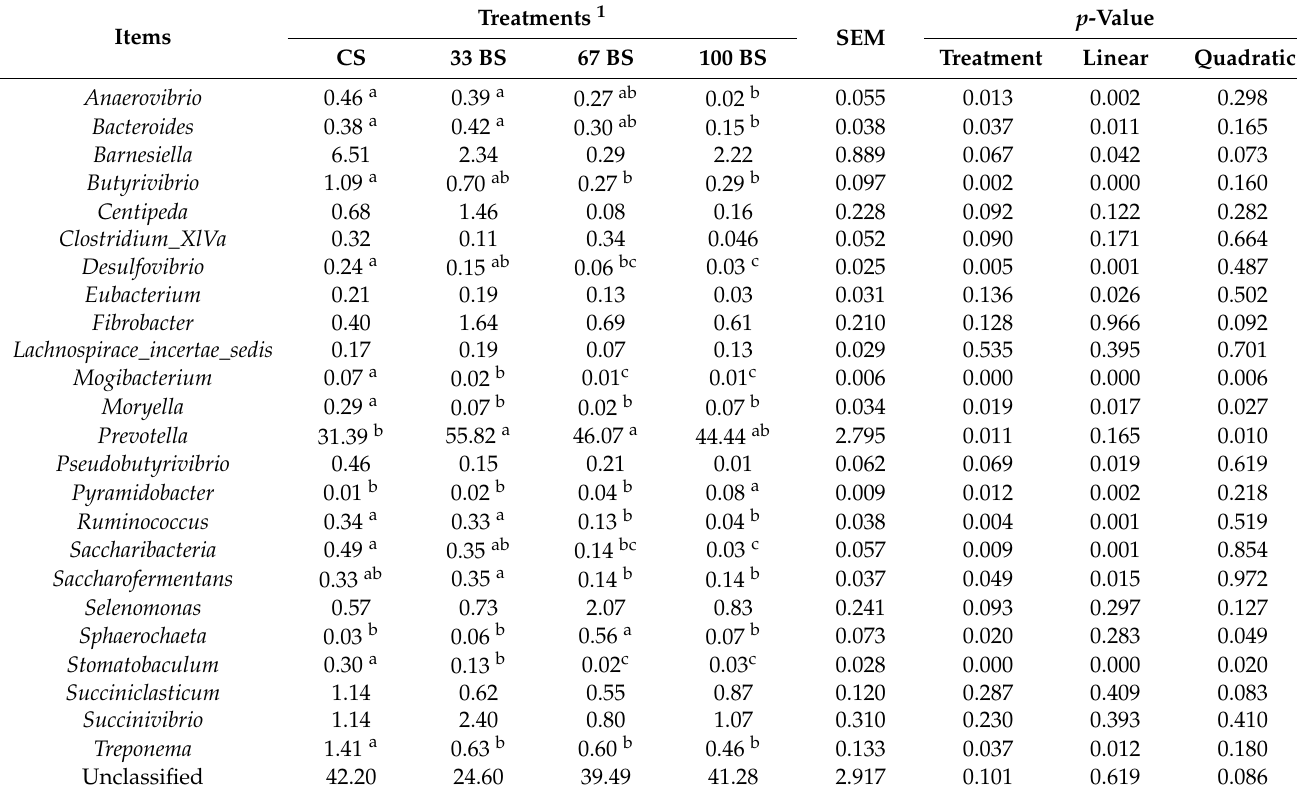
Table 6. Effects of dietary barley starch levels on relative abundances of dominant genera at 2 h after morning feeding in the rumen of Hu sheep.